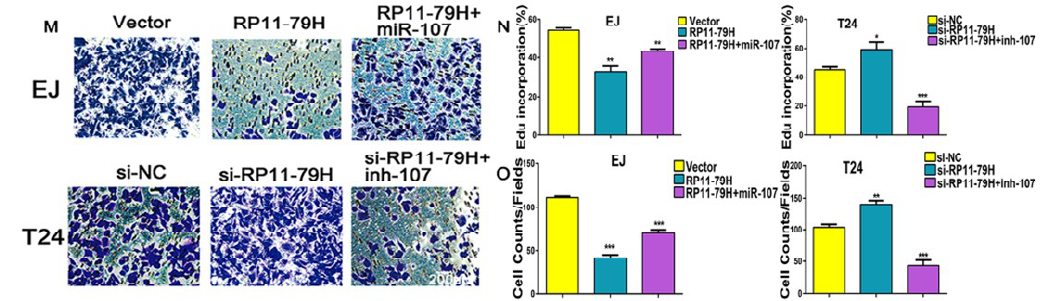
Figure 6. RP11-79H23.3 and PTEN could competitively bind to miR-107. ( A ) The miR-107 binding sites on RP11-79H23.3 and PTEN were predicted by miRcode and TargetScan, respectively. ( B ) Schematic of RP11-79H23.3 wild-type (wt) and mutant (mut) luciferase reporter vector is shown. ( C ) Schematic of miR107 and the putative binding sequence in the 3′-UTR sequence of PTEN as well as the mutant sequence of PTEN 3′-UTR for luciferase assays is shown. ( D ) The relative luciferase activities of EJ cells were tested after co-transfection with pmirGLO-RP11-79H23.3-wt or pmirGLO-RP11-79H23.3-mut and miR-107 mimics or miR-NC. ( E ) The relative luciferase activities were analyzed in EJ cells co-transfected with inh-107 or inh-NC and luciferase reporter vectors pmirGLO-RP11-79H23.3-wt or pmirGLO-RP11-79H23.3-mut. ( F ) The relative luciferase activities were analyzed in EJ cells co-transfected with miR-107 mimics or miR-NC and luciferase reporter vectors pmirGLO-PTEN 3′UTR-wt or pmirGLO- PTEN3′UTR-mut. ( G ) The subcellular localization for RP11-79H23.3 and miR-107 was detected in BC cells with FISH (scale bar, 20 µm). ( H ) The schematic diagram of GFP-MS2-RIP is shown. ( I ) GFP-MS2-RIP followed by qRT-PCR to detect miR-107 and endogenously associated RP11-79H23.3 in EJ cells. ( J ) Anti-AGO2 RIP was executed in EJ cells transiently transfected with miR-107 mimics, followed by RT-PCR and qRT-PCR to detect miR-107 and RP11-79H23.3 associated with AGO2. ( K ) The relative luciferase activities were analyzed in EJ cells co-transfected with luciferase reporter vectors pmirGLO-PTEN 3′UTR-wt and pIRES2-RP11-79H23.3 or vector or/and miR-107 mimics or miR-NC. ( L , N ) EdU assay showed that ectopic expression of miR-107 abolished the decreased proliferation by RP11-79H23.3 overexpression in EJ cells, whereas miR-107 inhibitor reversed the increased proliferation by RP11-79H23.3 knockdown in T24 cells (scale bar, 100 µm). ( M , O ) Transwell assay indicated that overexpression of miR-107 relieved the reduced invasion by upregulation of RP11-79H23.3 in EJ cells, whereas co-transfected miR-107 inhibitor abated the increased invasion by siRP11-79H23.3 in T24 cells (scale bar, 100 µm). Each experiment was independently repeated at least three times. Data is shown as mean ± SD, * p < 0.05, ** p < 0.01, *** p < 0.001.